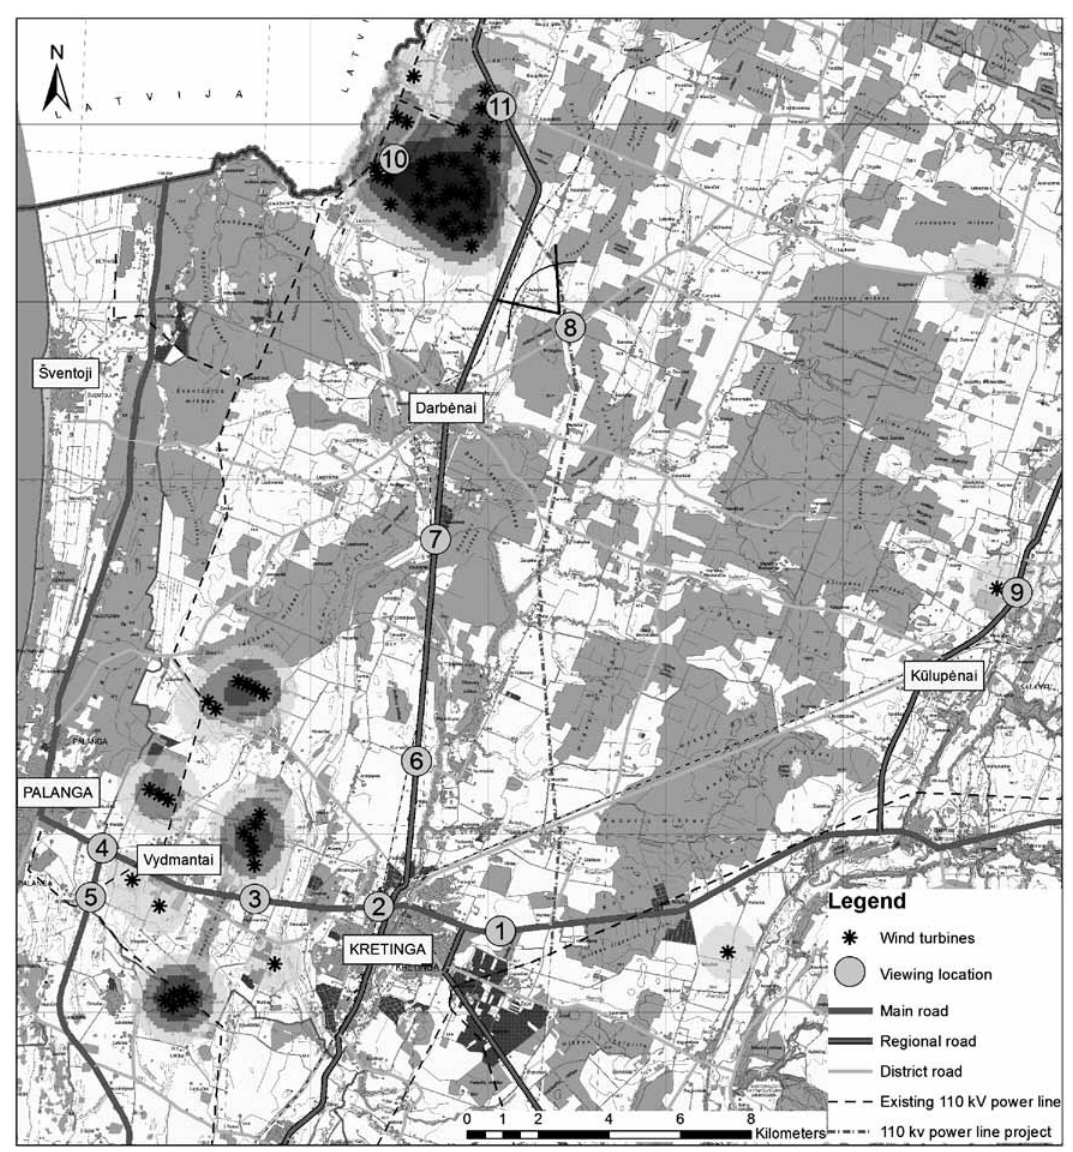
Fig. 2. Locations of wind turbines, their farms (WT farms) and viewing points and the levels of wind turbines concentration (author of the map: J. Abromas,